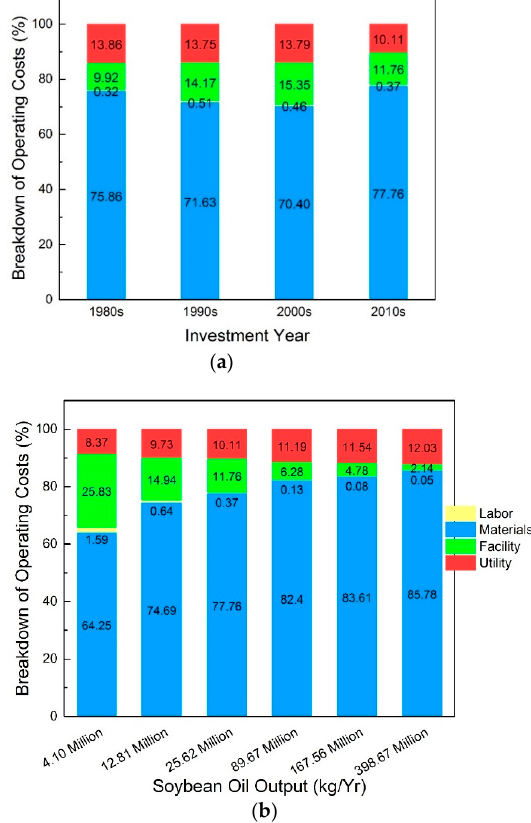
Figure 4. Breakdown of operating costs. ( a ) 1980–2015 data; ( b ) Different scales of oil expelling based on 2010s inputs only.